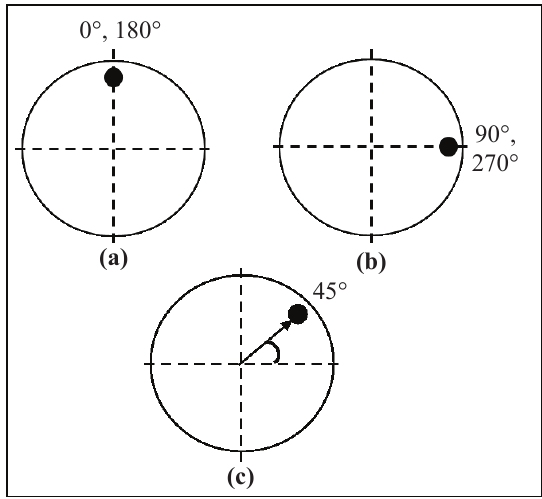
Fig. 6. Rotational angle of He-Ne